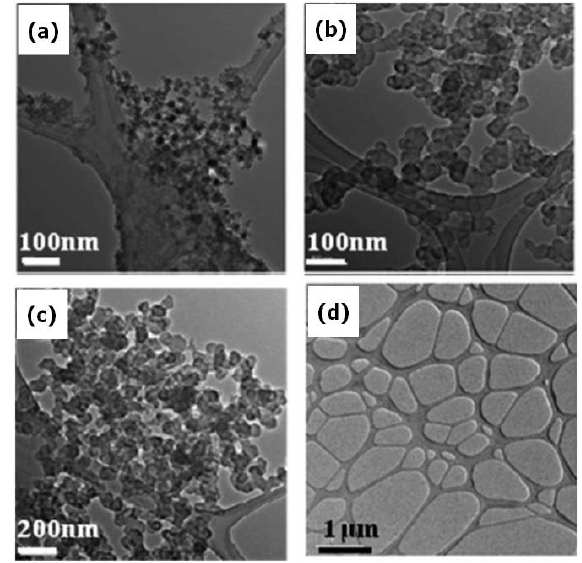
Figure 8. TEM image of CdS nanoparticles generated from the continuous flow microreactor with a residence time of ( a ) 1, ( b ) 3.5 and ( c ) 70 s by preheating the precursor solutions and with a residence time of ( d ) 1 s for the precursor at room temperature. Reproduced from